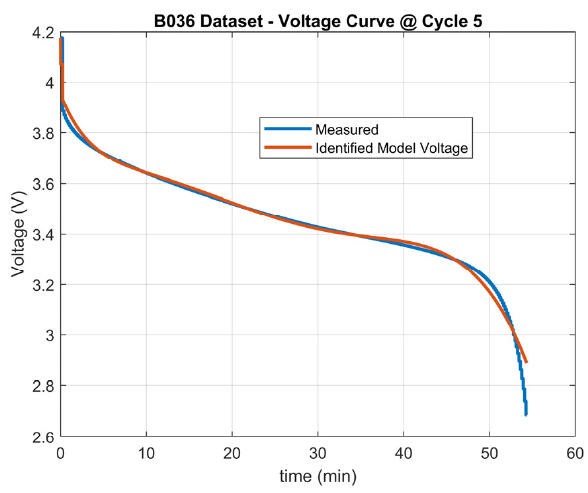
Figure 5. B036 terminal voltage: model vs. measured voltage.